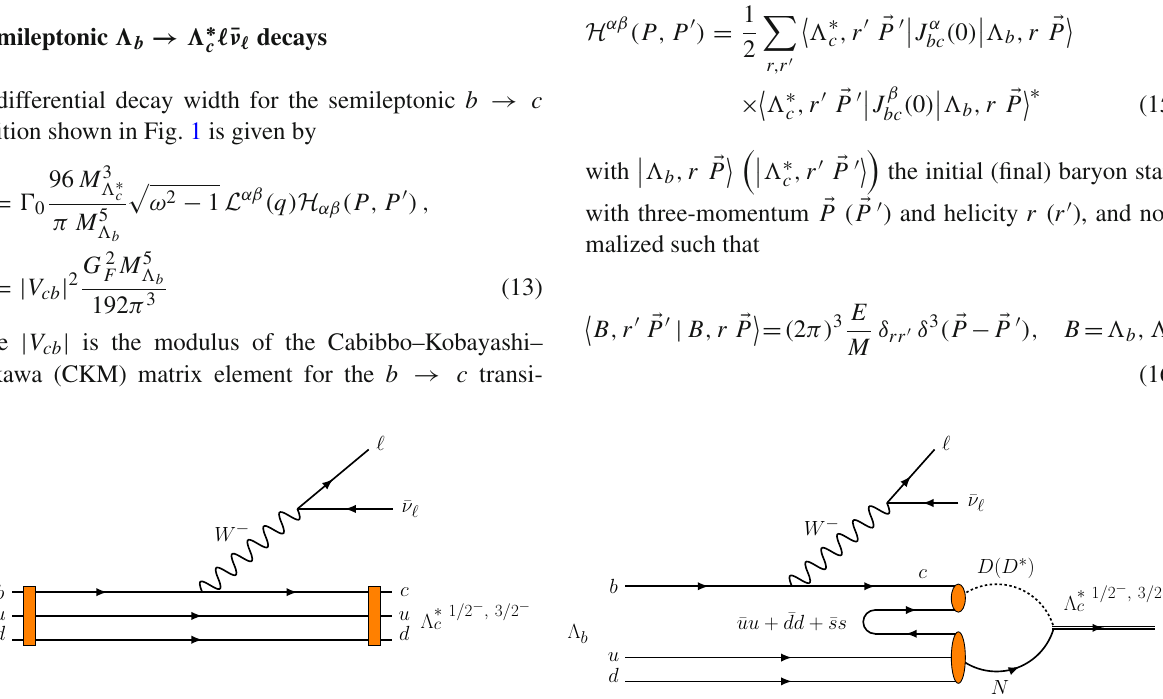
Fig. 1 Left: Diagrammatic representation of the (cid:2) b → (cid:2) ∗ c (cid:3) ¯ ν (cid:3) decay. Right: Hadronization creating q ¯ q pairs, together with the pictorial represen- tation of the mechanism to produce a (cid:2) ∗ c resonance, through an intermediate propagation of DN and D ∗ N